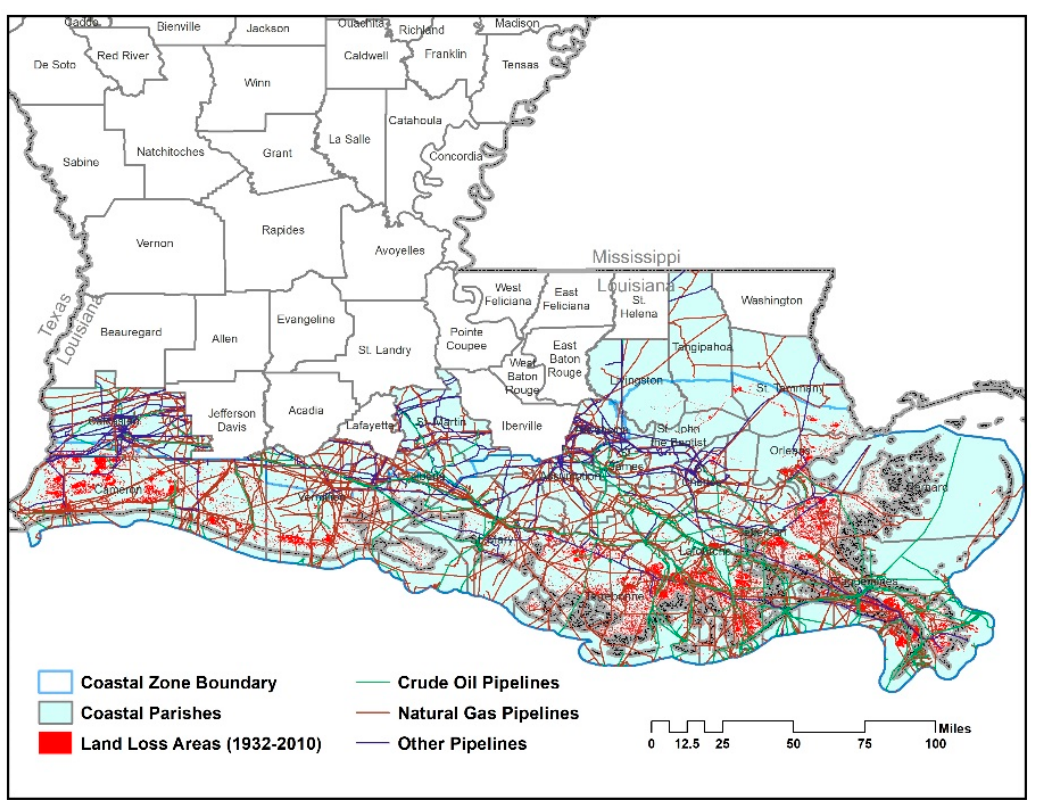
Figure 2. The pipelines crisscrossing in coastal Louisiana.